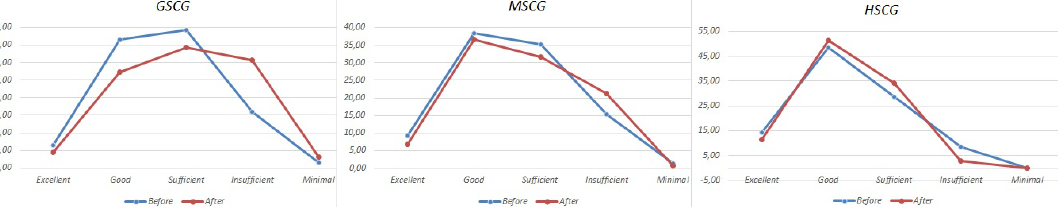
Figure 1. How do you assess your knowledge on information